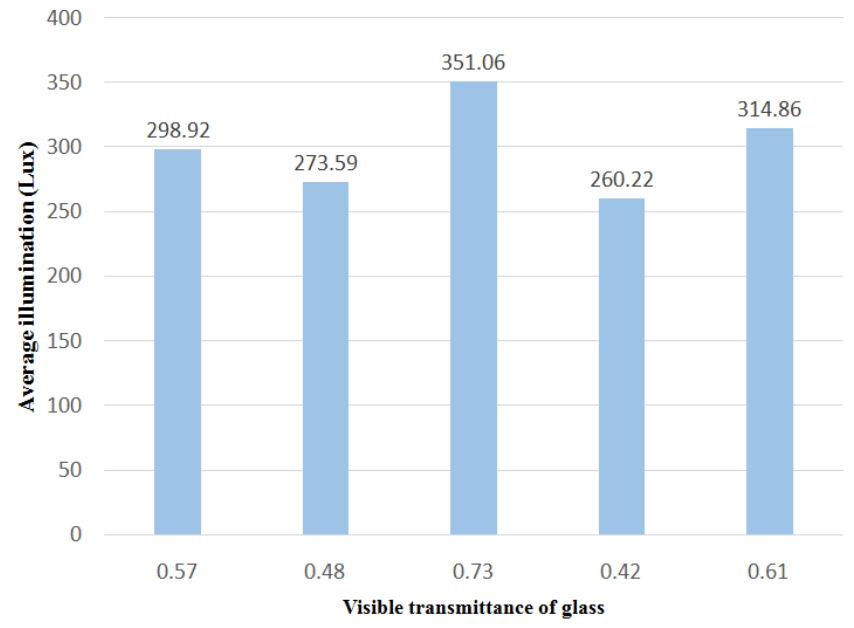
Fig. 7 Average illumination of the